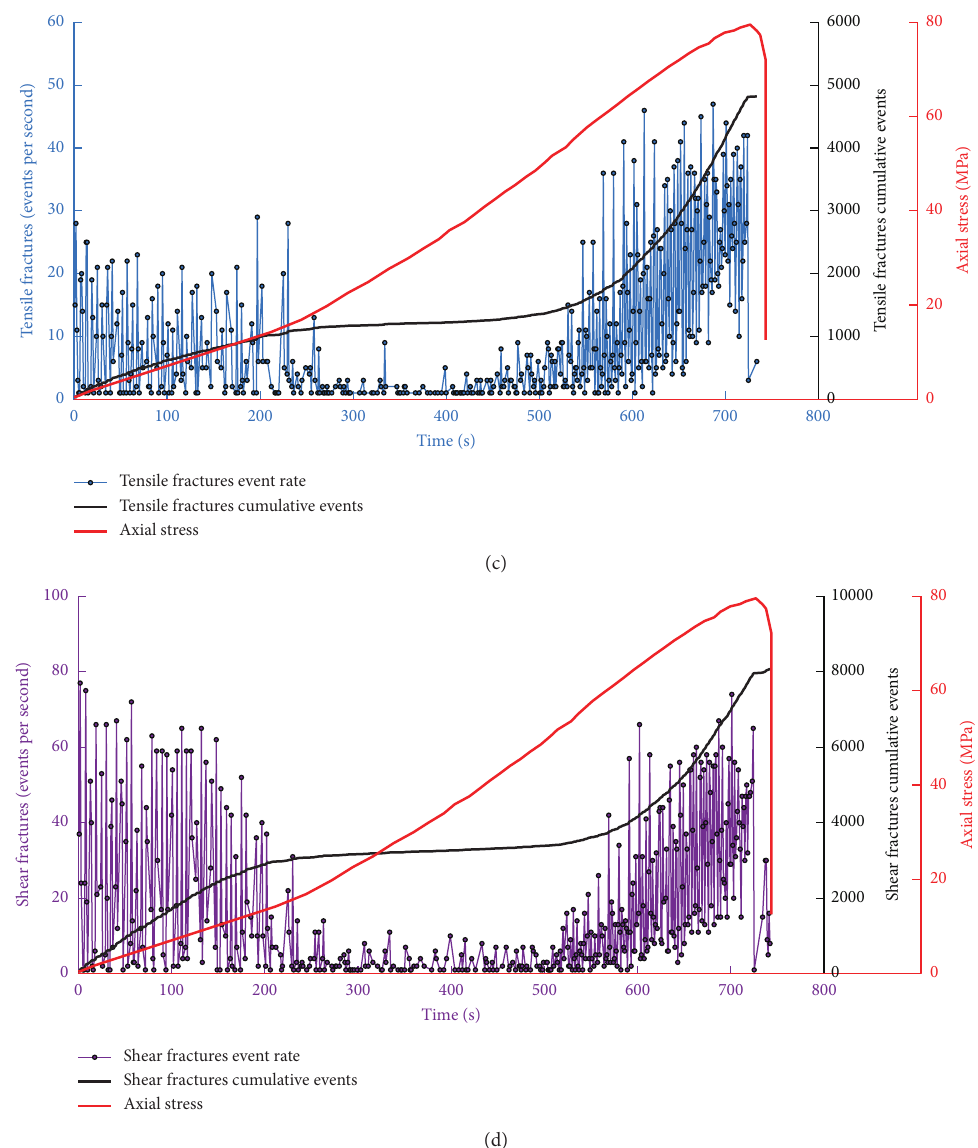
Figure 9: Evolution characteristics of AE fractures mode event number and cumulative event rate. (a) Brazilian split (specimen BT-1). (b) Preset angle shear (specimen CS-2). (c) Uniaxial compression (specimen UC-1, tensile fracture). (d) Uniaxial compression (specimen UC-1, shear